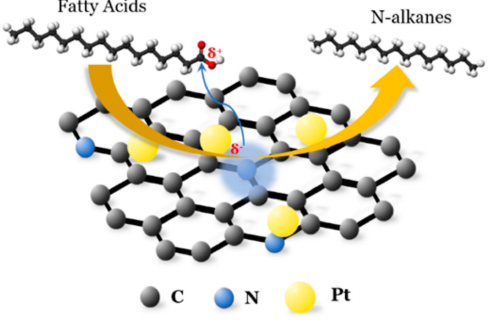
Figure 10. The scheme of catalytic deoxygenation of palm oil over Pt / N-AC